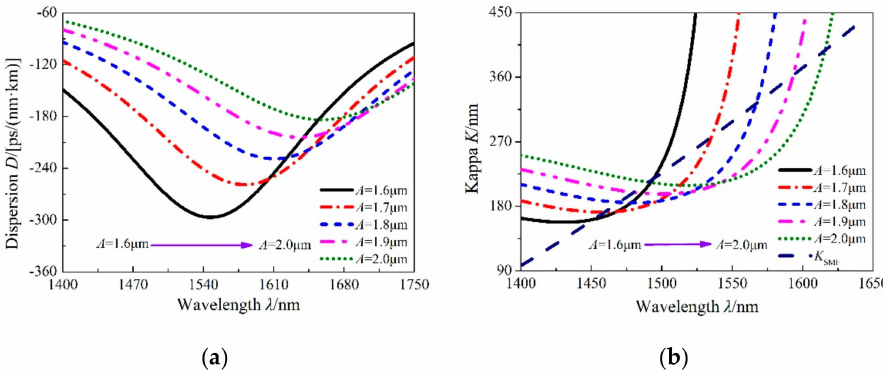
Figure 7. Variation of dispersion ( a ) and K value ( b ) with Λ